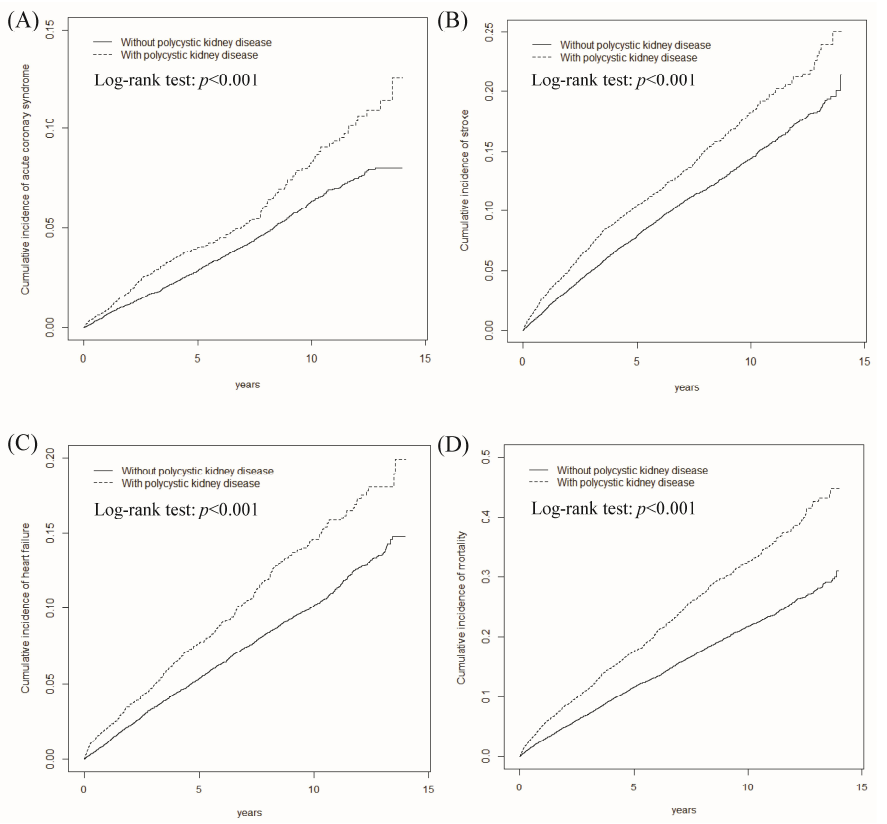
pulmonary disease. ESRD: end-stage renal disease.